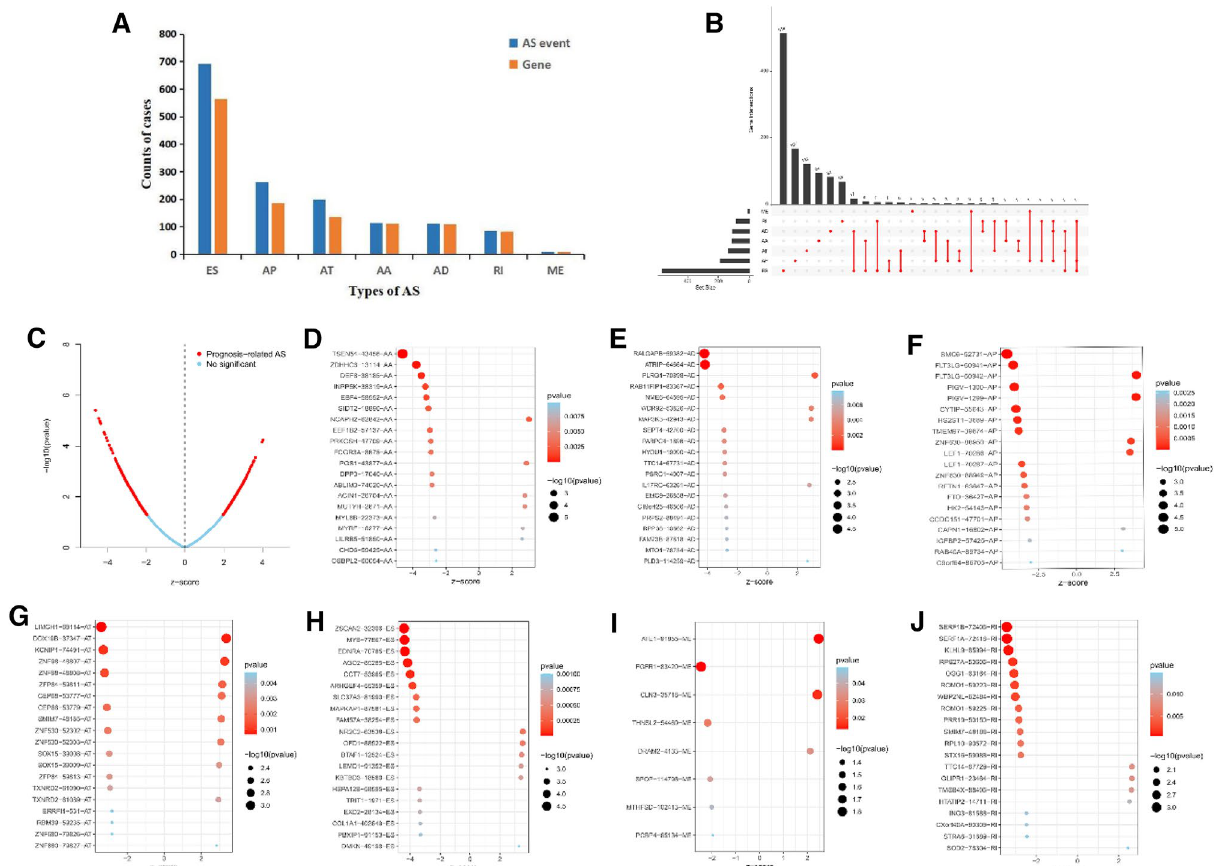
Figure 2. Top 20 significant AS events of OC. ( A ) Counts of survival-associated AS events and correlated genes. ( B ) Upset plot of interactions diagram of survival-associated AS events. ( C ) The volcano plot of survival- related AS events (red dots). Red dots indicate survival-related AS events in OC. Blue dots indicate AS events unrelated to survival in OC. Bubble plots of the top 20 survival-related AS events based on AA ( D ), AD ( E ), AP ( F ), AT ( G ), ES ( H ), ME ( I ), and RI ( J ), respectively.